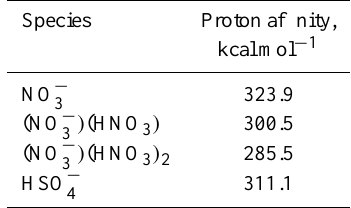
Table 2. Proton affinities (at the PW91/6-311++G(3df, 3pd) level) for the hydrogensulfate ion and various nitrate ion – nitric acid